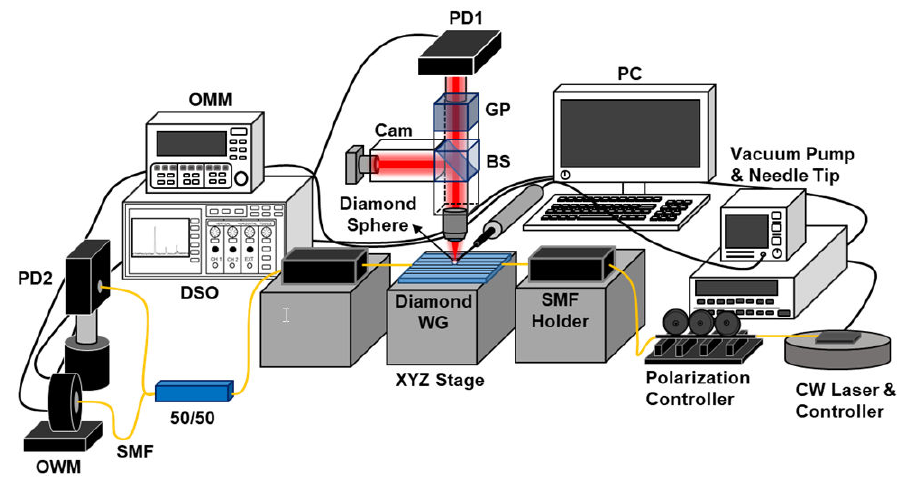
Figure 3. The measurement setup to acquire the 90 ◦ elastic light scattering and the 0 ◦ transmitted optical power to measure the microsphere whispering gallery modes (WGMs) and the waveguide Fabry–P é rot